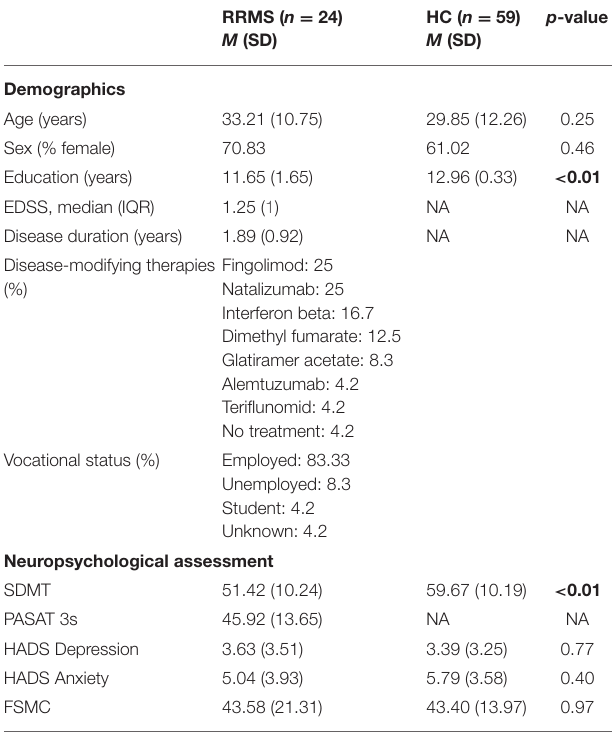
TABLE 2 | Demographic and clinical characteristics of the RRMS and HC